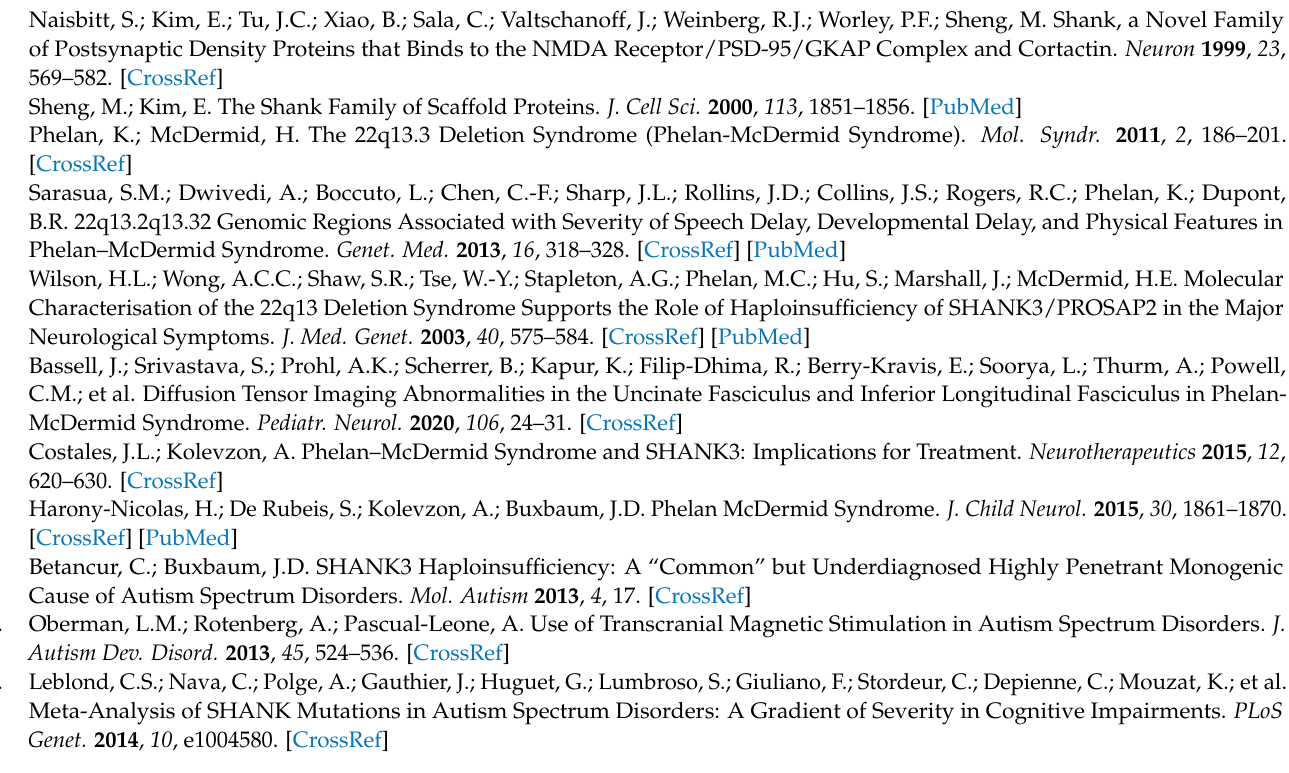
Figure A4. Illustration of Hilbert transformation performed for the analysis of ASSR. Red line corresponds with the signal obtained after filtering the data (35–45 Hz) and averaging all good trials. Blue line indicates Hilbert transformation of 35–45 Hz filtered